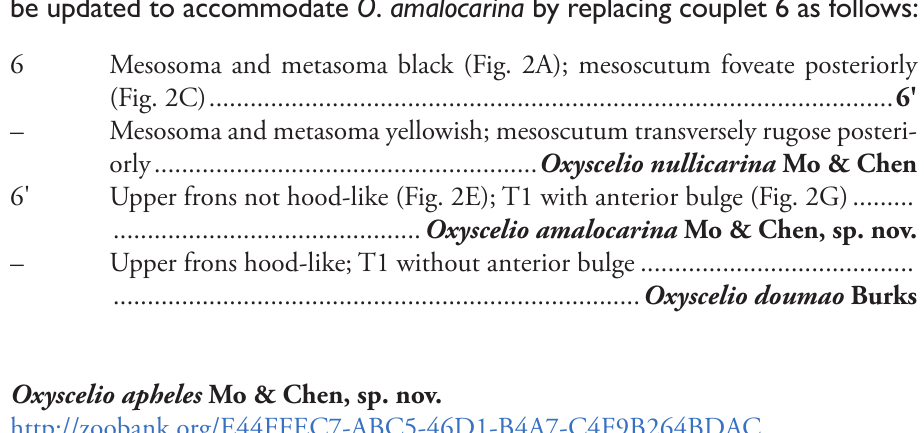
Figure 3 Description. Female. Body length 3.08 mm (n = 1). Radicle color: same color as scape. Scape color: dark brown. A4: as long as broad. A5: broader than long. Antennal club in female: formed, segments compact. Interantennal process: not elongate. Median longitudinal elevation in frontal de- pression: absent. Frontal depression: concave. Frontal depression sculpture: with 3 broadly interrupted transverse carinae below submedian carina. Submedian carina: strong, formed by a sharp raised carina. Submedian carina medially: with sharp peak. Concavity across dorsal part of frontal depression: absent. Depression extending ven- trally from median ocellus: absent. Upper frons: not hood-like. Malar area near anten- nal foramen: without carina or expansion. Facial striae: present. Smooth strip